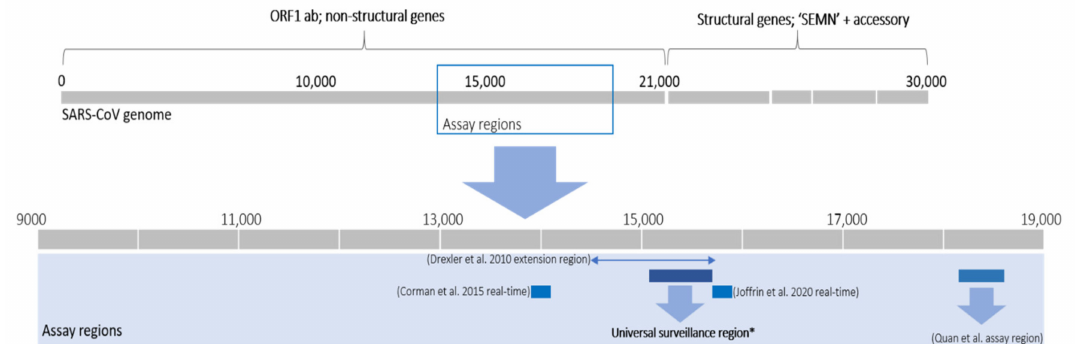
Figure 4. Representation of the coronavirus genome (based on the reference genome NC_004718.3 SARS coronavirus Tor2) depicting the assay regions. The assays corresponding to this universal region included in Tong et al. [26], de Souza Luna [62], Geldenhuys et al. [42] and Geldenhuys et al. [32] (based on primers from Woo et al. [63]), Razanajatovo et al. [47] (based on Poon et al. [14]), Shehata et al. [27], Waruhiu et al. [29] (based on Watanabe et al. [64]), Chu et al. [65], Gouilh et al., [33]. The RdRp grouping units (RGU) amplification region by Drexler et al. [66] is indicated with the line and